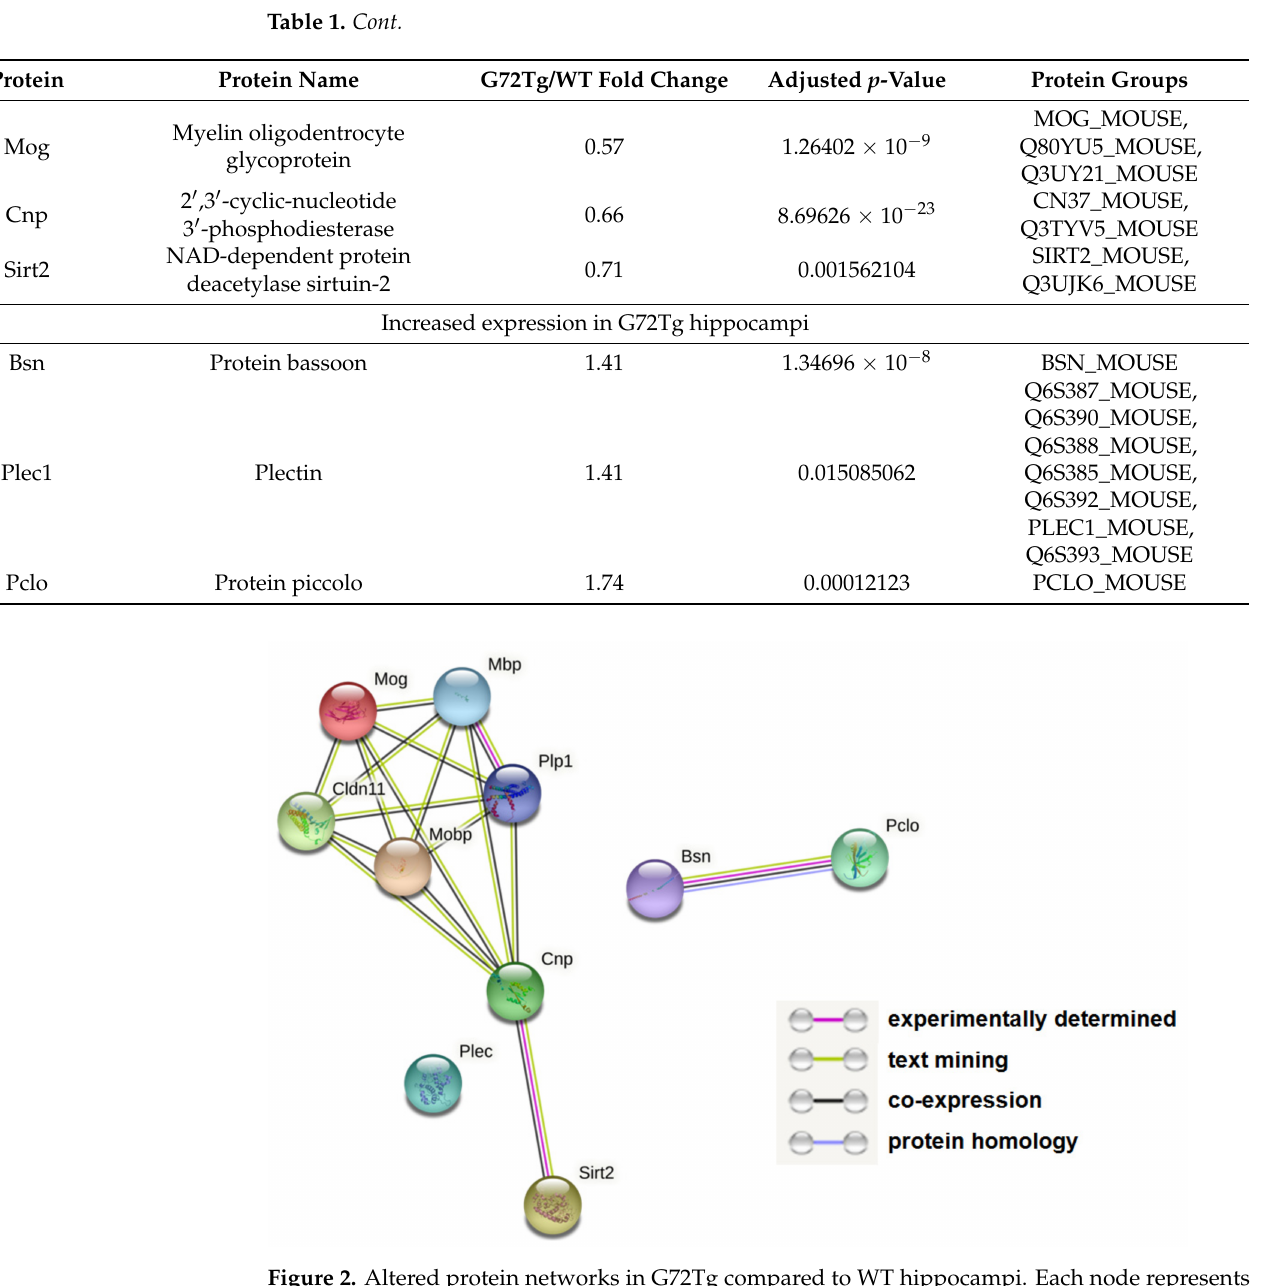
Figure 2. Altered protein networks in G72Tg compared to WT hippocampi. Each node represents a protein. Lines connecting the nodes indicate functional and physical associations between the respective proteins. Line color denotes the type of evidence for the reported association, as